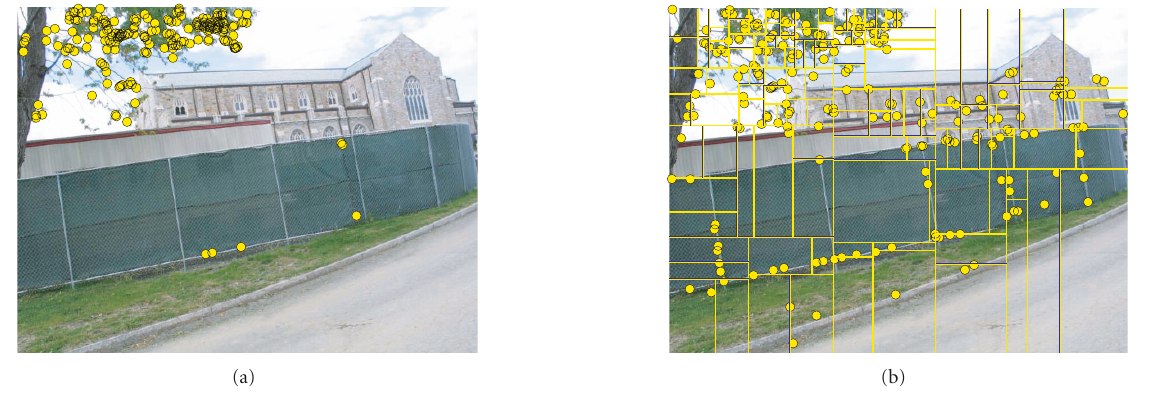
Figure 2: The goal is to select 256 representative features in the image. (a) The 256 strongest features are concentrated in a small area in the image—more than 95% are located in the tree at upper left. (b) After applying the k-d tree partition with 128 leaf nodes, the features are more uniformly spatially